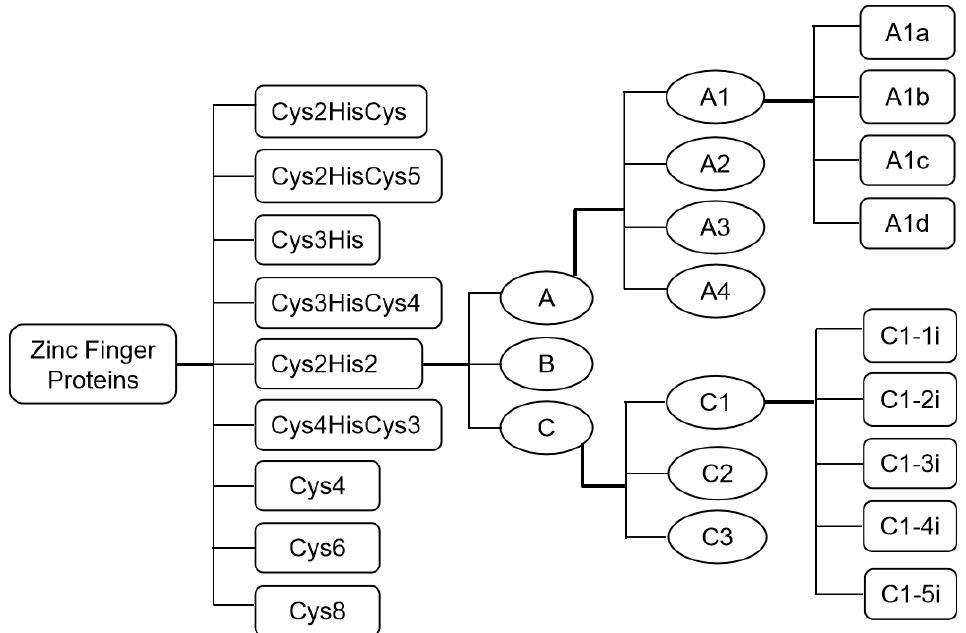
Figure 1. Zinc-finger protein (ZFP) family assignment rules used to identify and assign genes into different subfamilies in Arabidopsis [2]. Cys: cysteine; His: histidine; Cys2His2 indicates the presence of two cysteine and two histidine residues in the structure of the ZFP. Cys2His2-type ZFPs are divided into three sets, namely A, B, and C. Set A can be further subdivided into four subsets: A1, A2, A3, and A4. Set C can be further subdivided into three subsets, C1, C2, and C3. The A1 subset is categorized into four subclasses: A1a, A1b, A1c, and A1d, whereas the C1 subset is categorized into five subclasses, namely C1-1i, C1-2i, C1-3i, C1-4i, and C1-5i. 1i indicates one zinc finger, 2i is two zinc fingers, 3i is three zinc fingers, 4i is four zinc fingers, and 5i is five zinc fingers.